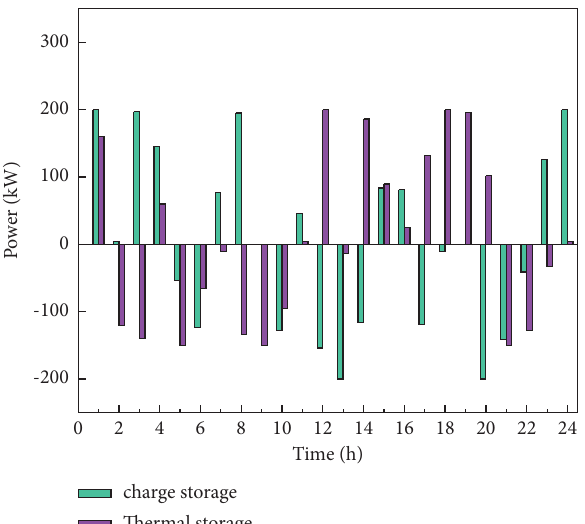
Figure 10: Te details of the energy storage output.